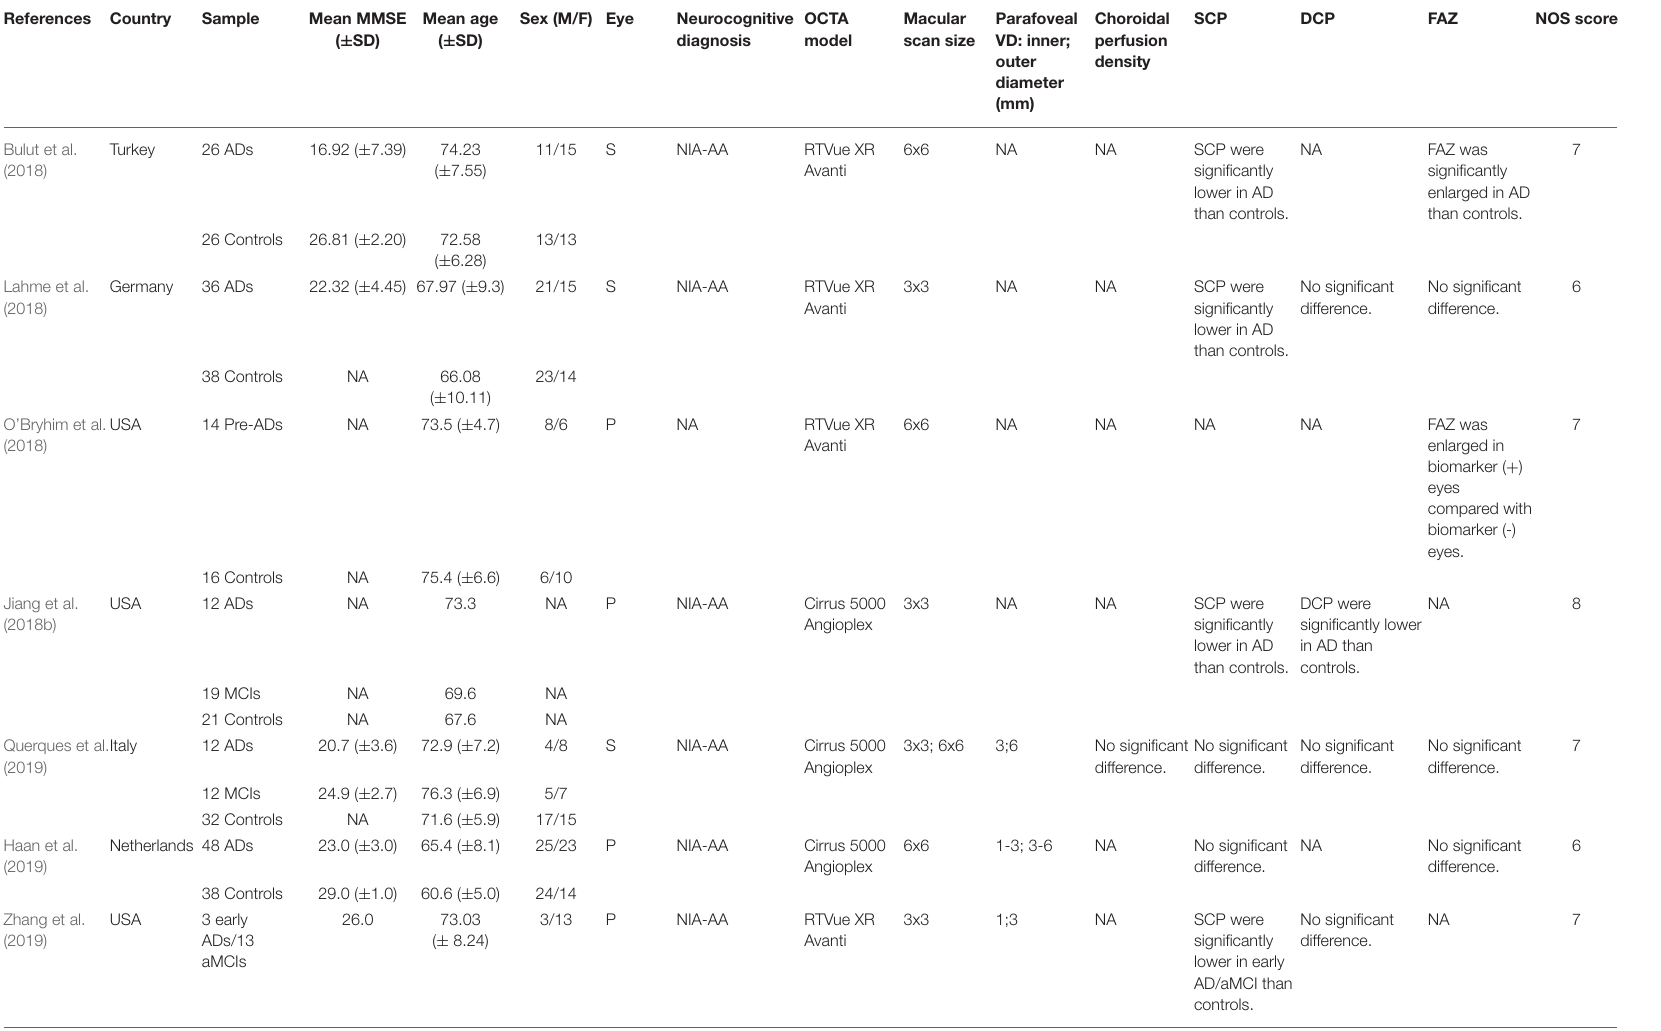
TABLE 2 | Summary of included case control studies on individuals with Alzheimer’s disease and mild cognitive